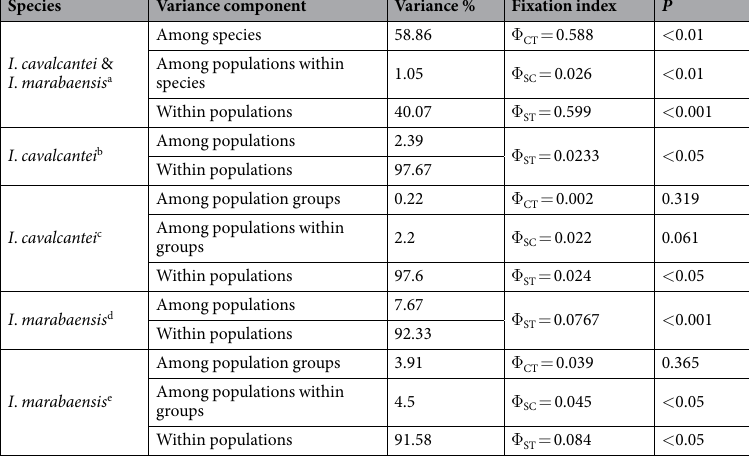
Diversification of transcribed internal ribosomal RNA gene spacer.